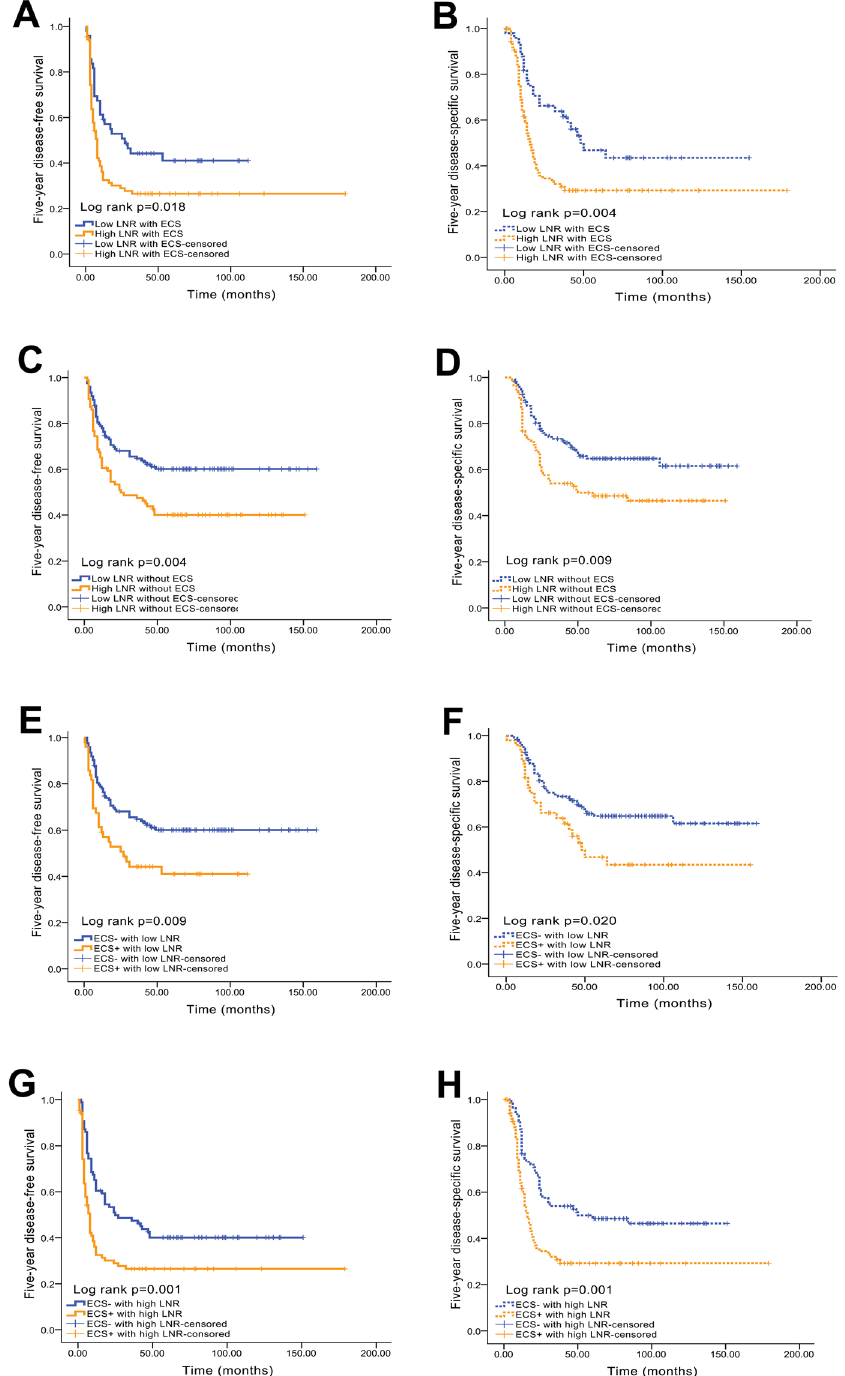
Figure 3. Kaplan-Meier analyses of 5-year DFS and DSS between the LNR and ECS status. ( A ) Five-year DFS curve for the LNR in the ECS + subgroup; ( B ) 5-year DSS curve for the LNR in the ECS + subgroup; ( C ) 5-year DFS curve for the LNR in the ECS − subgroup; ( D ) 5-year DSS curve for the LNR in the ECS − subgroup; ( E ) 5-year DFS curve for the ECS status in the low LNR subgroup; ( F ) 5-year DSS curve for the ECS status in the low LNR subgroup; ( G ) 5-year DFS curve for the ECS status in the high LNR subgroup; ( H ) 5-year DSS curve for the ECS status in the high LNR